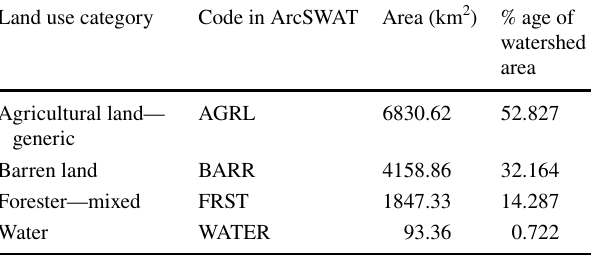
Table 2 Coverage areas of various land use/cover categories in the Hemren dam catchment area Land use category